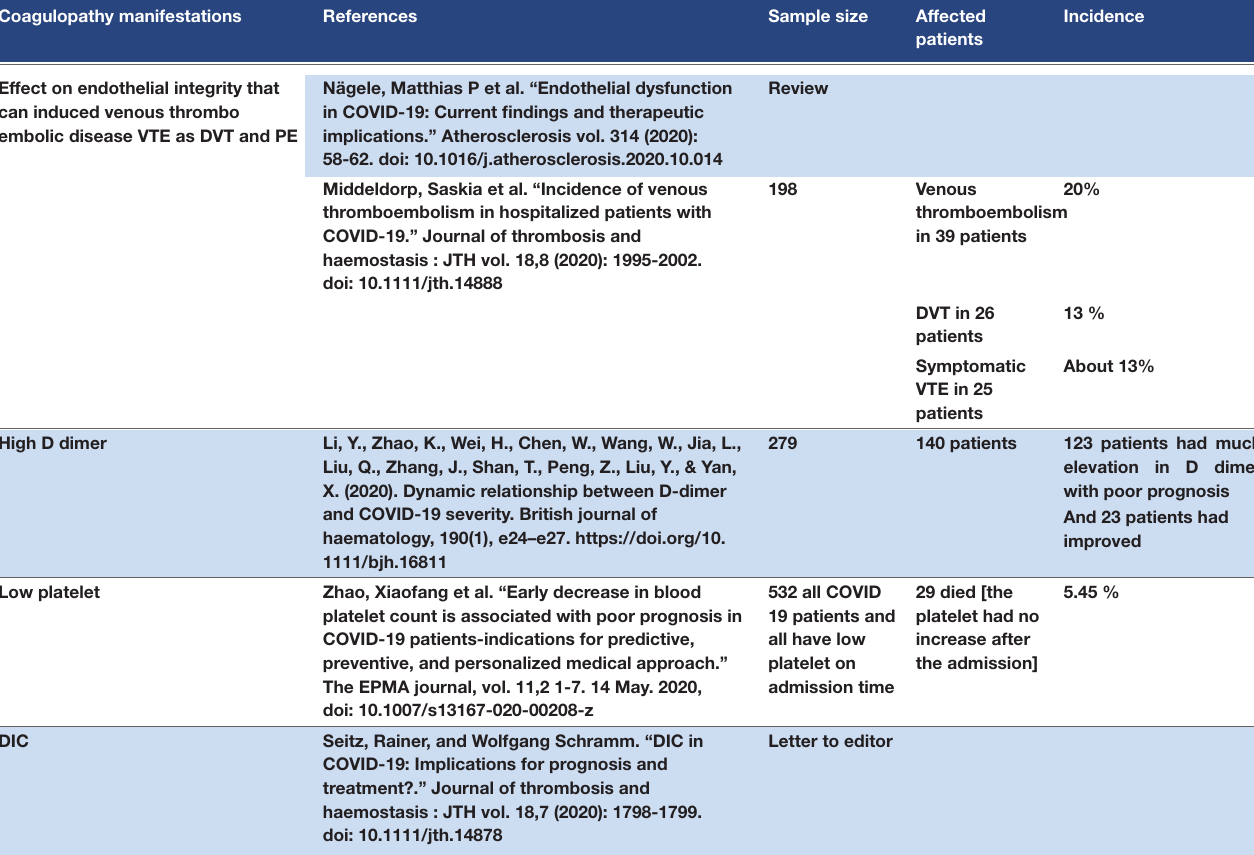
TABLE 12 | Coagulopathy manifestation of COVID